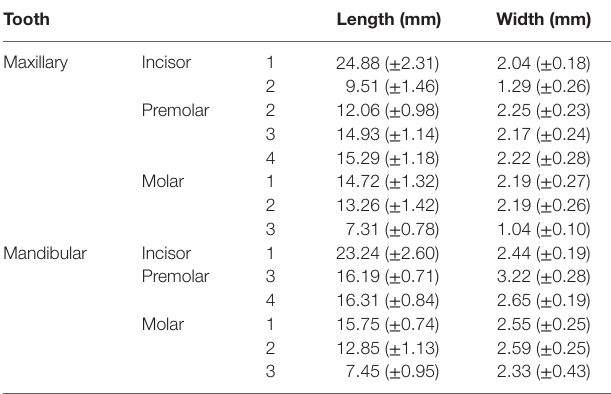
TaBle 1 | Mean length and width of teeth in ten rabbits without dental disease. Tooth length (mm) Width (mm) Maxillary